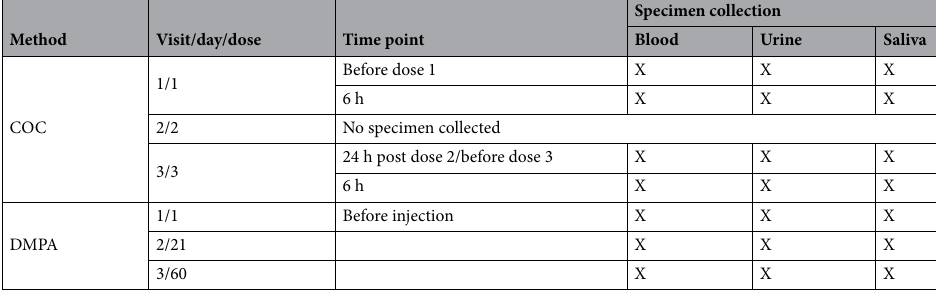
Table 1. Sample collection timepoints from participants using COCs or DMPA. Serum, urine, and saliva sample collection procedures and processing. Sample collections from participants using COC or Depo. The table shows each type of contraceptive method used and the type of sample: blood, urine, and saliva collected at various time